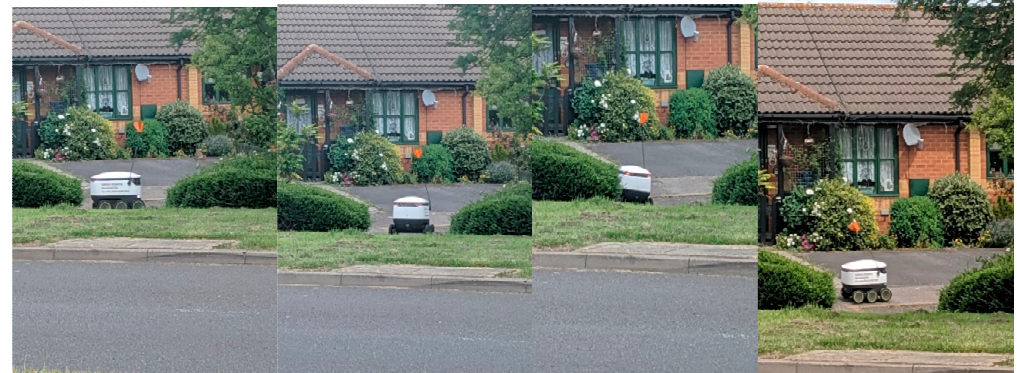
Figure 13. The delivery Robot travelling on public walkways towards to the delivery